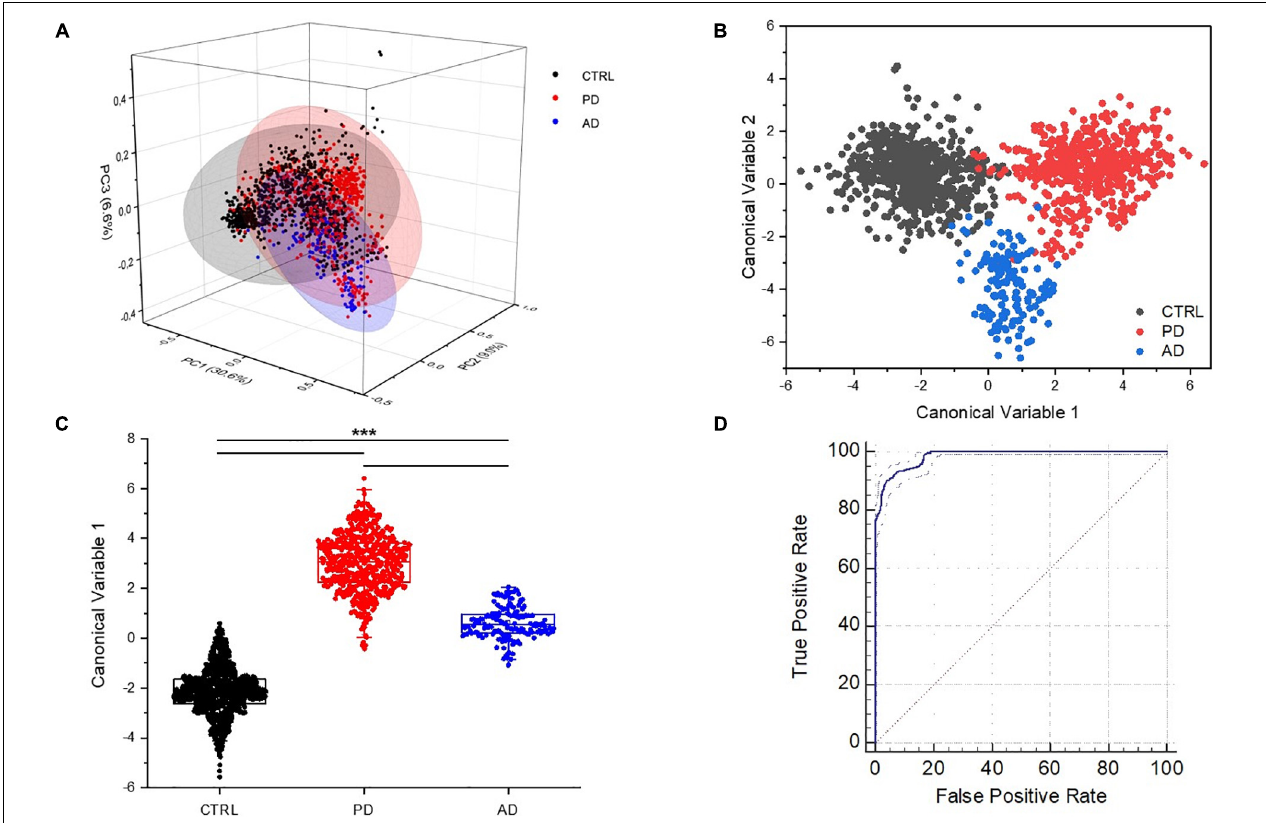
Figure 4 | (A) Principal component analysis (PCA) in three axis distribution ( X = PC1; Z = PC2; Y = PC3), covering the 45.83% of the loadings. Linear discriminant analysis (LDA) and spatial distribution of (B) the Canonical Variables 1 and 2 and (C) box plot of values of the Canonical Variable 1 with the statistical groups including CTRL ( n = 33), PD ( n = 23), and AD ( n = 10). *** p < 0.001, one-way ANOVA test. (D) Receiver operating characteristic (ROC) curve with the relative confidence interval (97–99%).